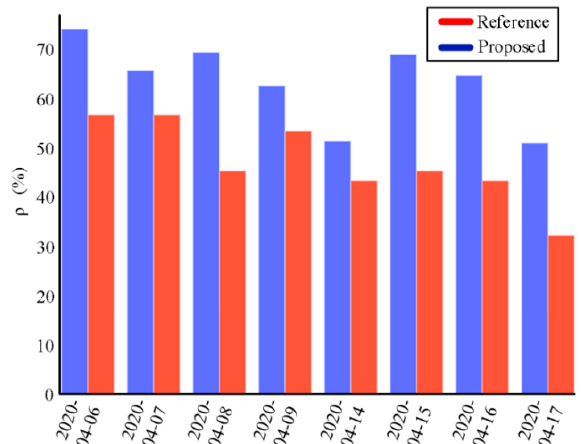
Figure 11. Compressor efficiency results. Comparison of percentage of time in high efficiency partial load ratio (PLR).